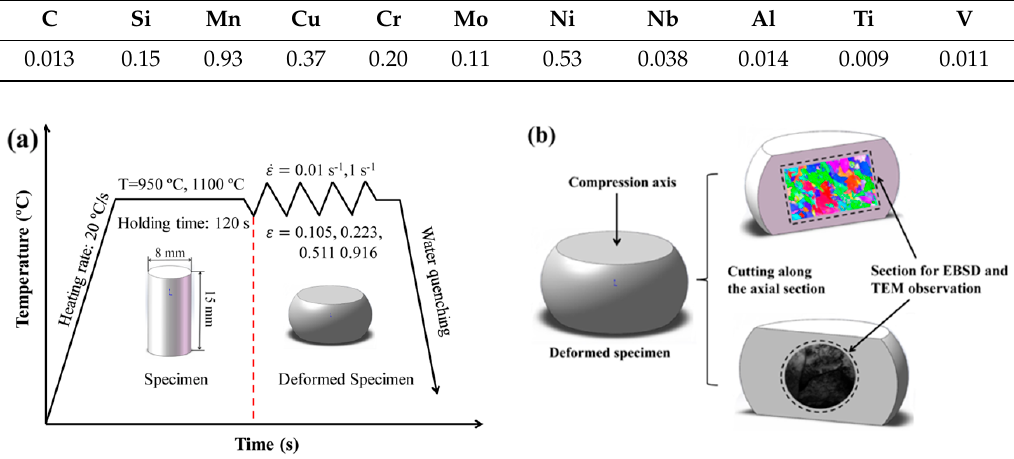
Figure 1. ( a ) The experimental process of the isothermal compression test; ( b ) the area of microstructure observation.